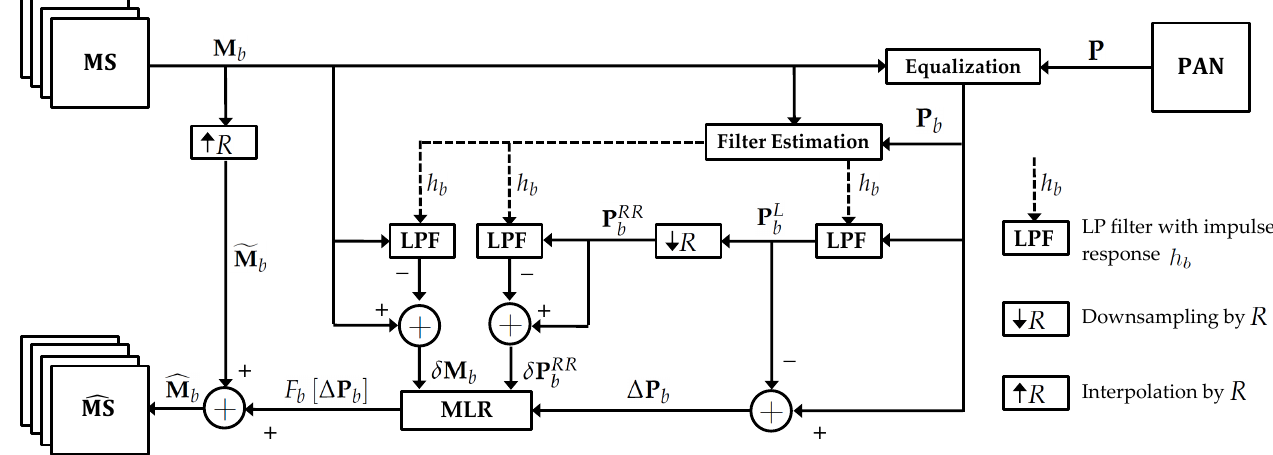
Figure 2. Block scheme of the pansharpening